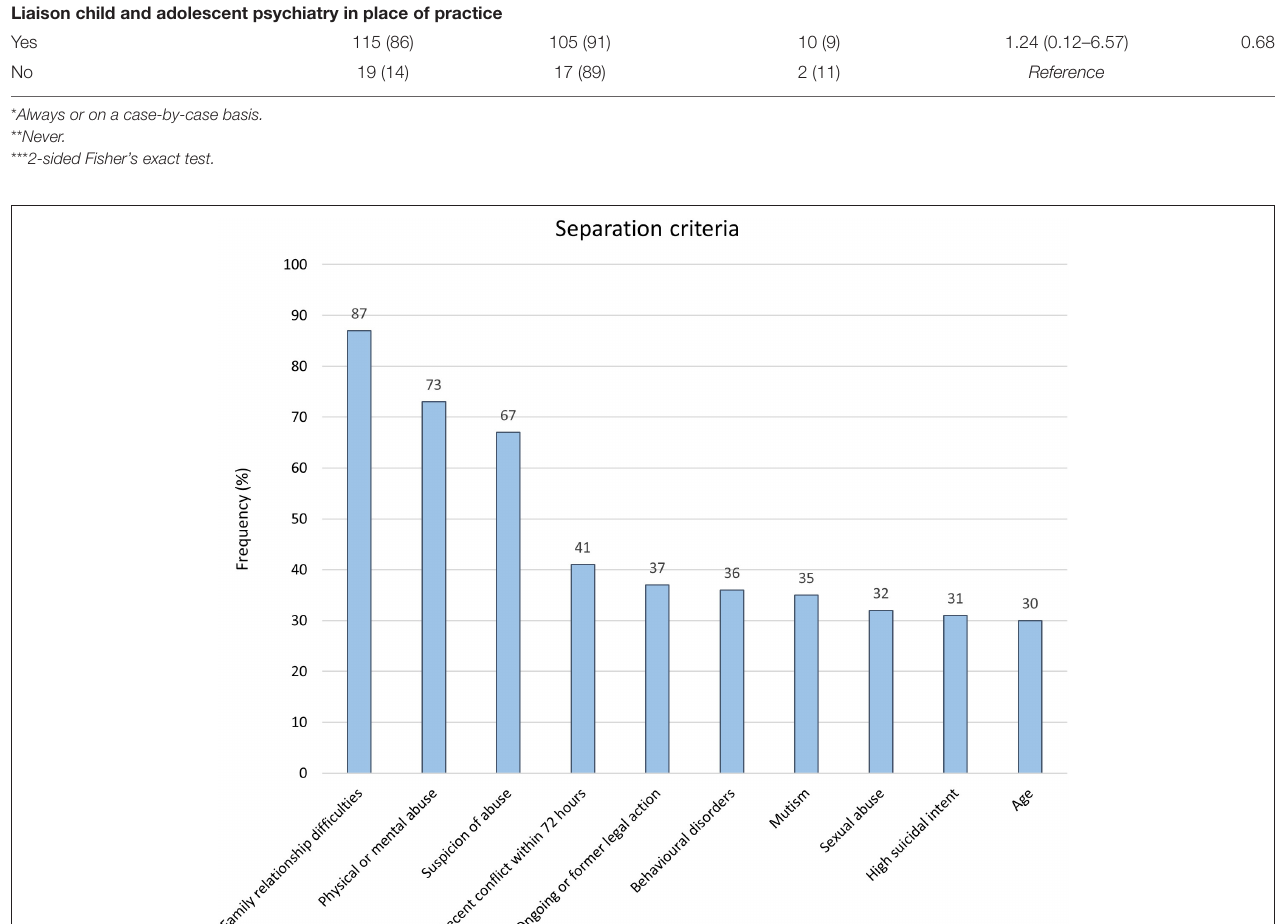
Frontiers in Pediatrics |